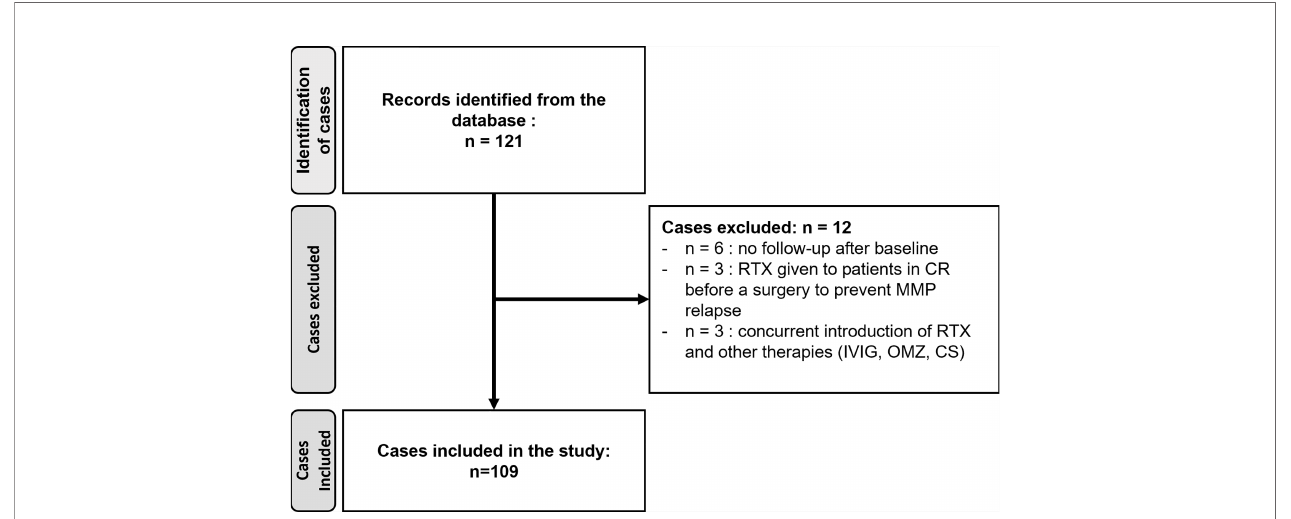
FIGURE 2 | Study fl ow